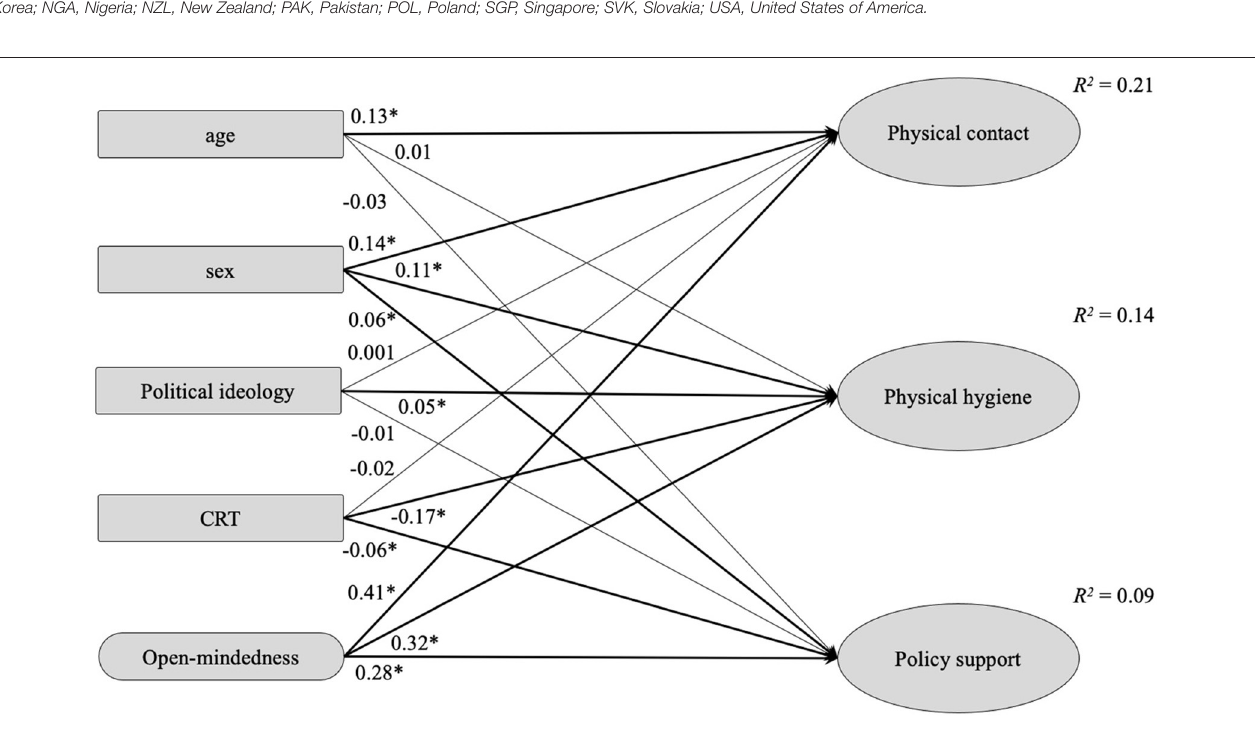
FIGURE 1 | Structural equation modeling of prediction of adherence to COVID-19 preventive behaviors (avoiding physical contact and maintaining physical hygiene) and COVID-19 policy support ( N = 12,490). Values shown are standardized regression coefficients. Latent variables are denoted as ellipse nodes, and observed variables are denoted as rectangle nodes. Sex coded as males = 1 and females = 2; CRT, cognitive reflection. * p <